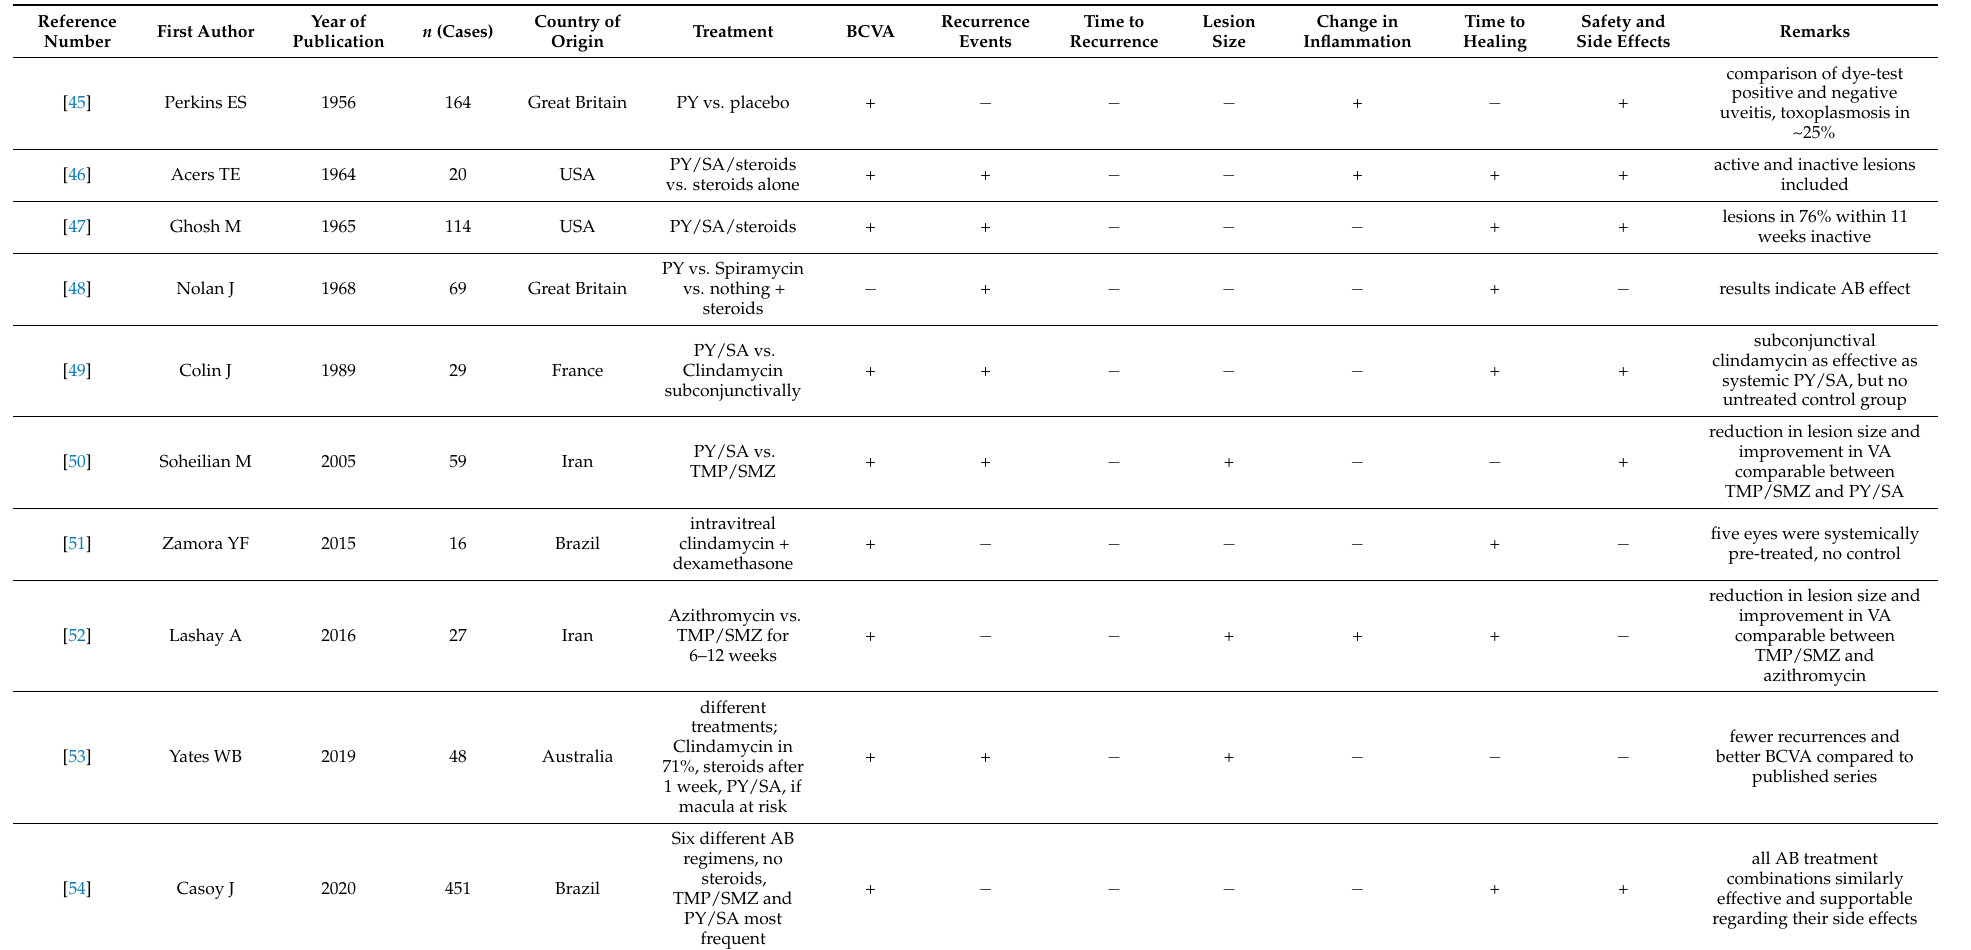
Table 1. Treatment of active ocular toxoplasmosis (OT). Overview over registered primary and secondary outcome